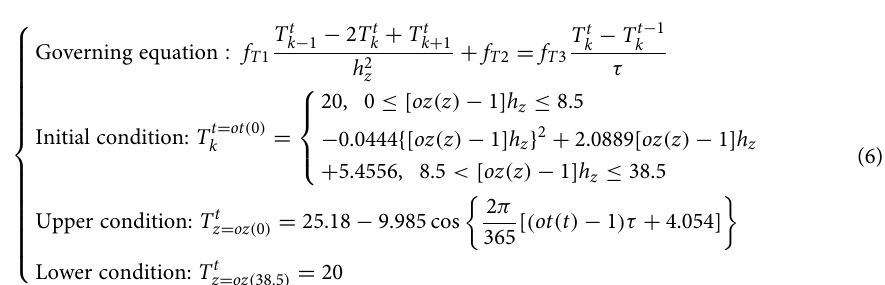
where ot ( t ) and oz ( z ) are the node functions in time and the vertical direction, respectively. In order to select reasonable calculation parameters, the parameters collected from the Wuxi landfill and those suitable for the Wuxi landfill were selected as far as possible. The parameters used in the numerical cal- culation are shown in Table 1. The variation in the waste temperature with time in the newly filled MSW layer